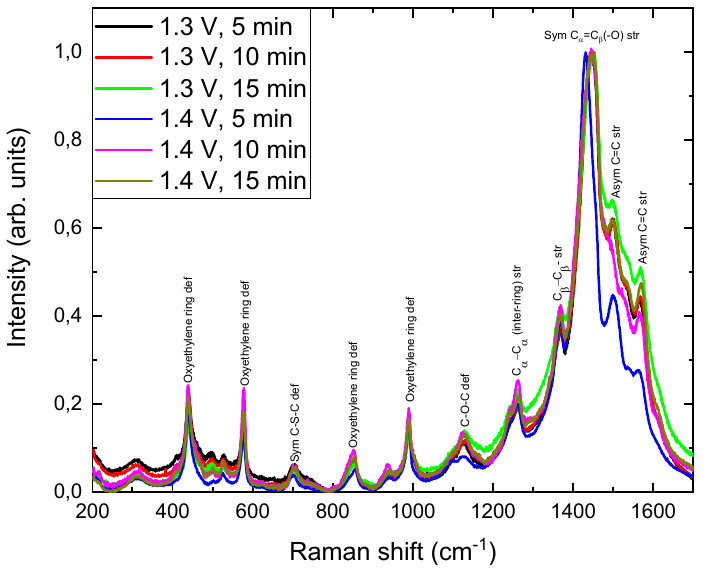
Figure 3. Raman spectra of the PEDOT films grown by electropolymerization under different oxidation potentials, i.e., 1.3 and 1.4 V, and electropolymerization times, i.e., 5, 10, and 15 min. Raman spectra were normalized to the band corresponding to the symmetric C α = C β ( ‐ O) stretching at 1445 cm − 1 . Table 2. Position, intensity, and the full width half maximum (FWHM) of the Raman vibration modes for the PEDOT films prepared by electropolymerization under different oxidation potentials, i.e., 1.3 and 1.4 V, and electropolymerization times, i.e., 5, 10, and 15 min.